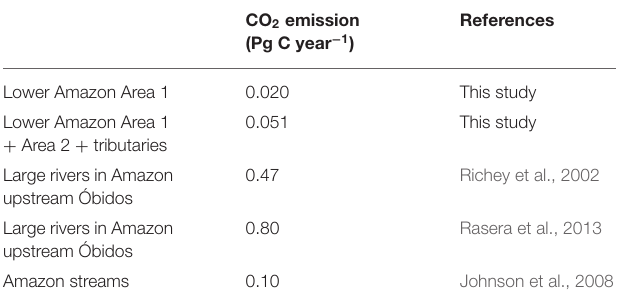
TABLE 4 | CO 2 emission estimates for rivers and streams in the